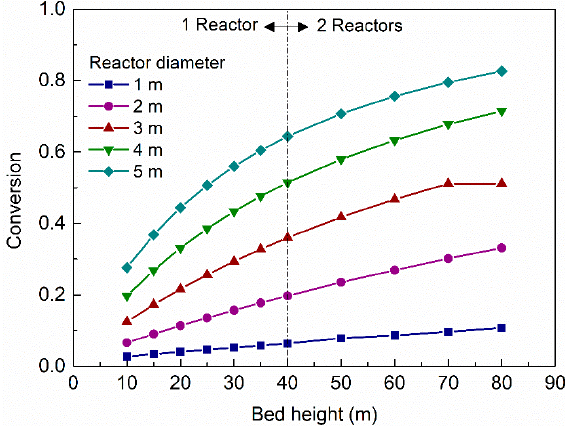
Figure 5. Impacts of bed height on pyrolytic oil conversion.